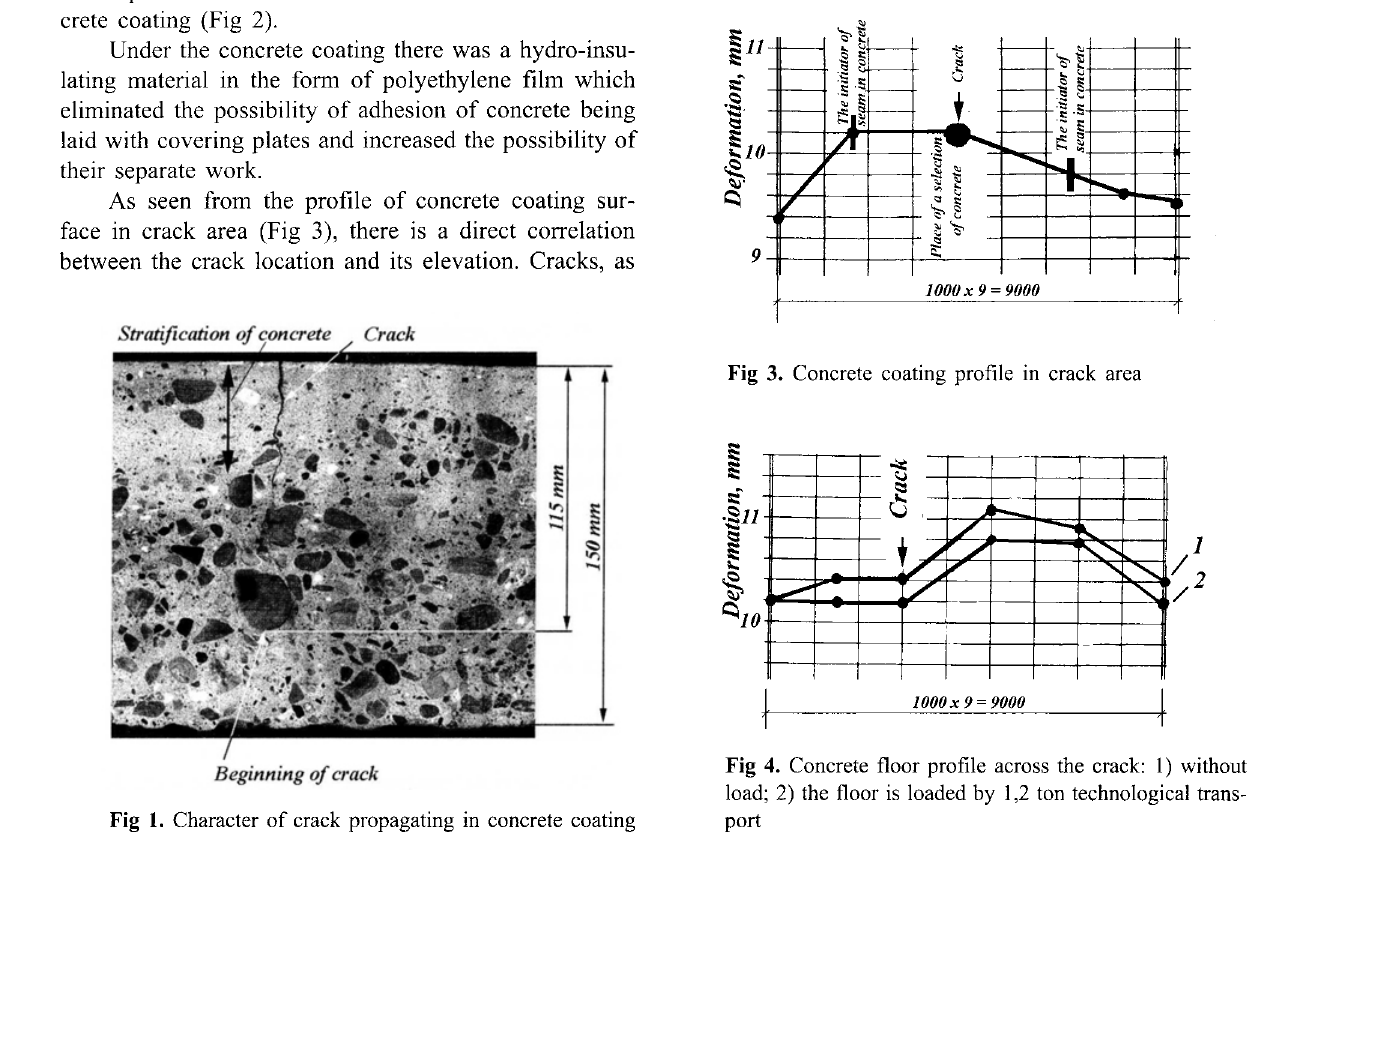
Fig 1. Character of crack propagating in concrete coating